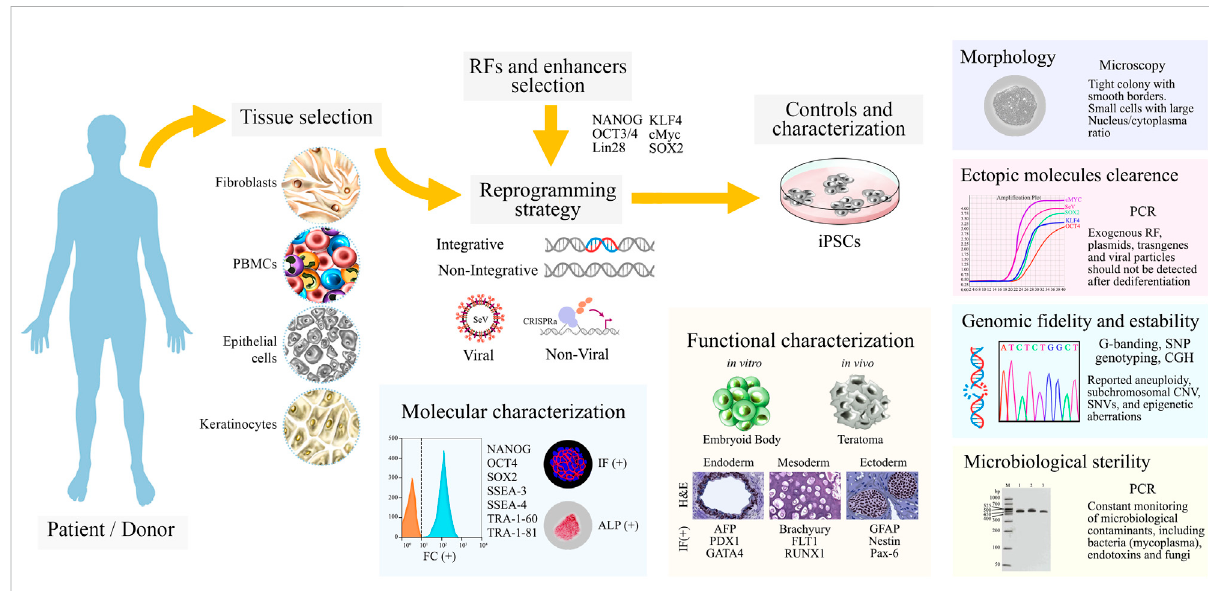
FIGURE 2 A schematic overview from patient ’ s tissue sample to characterized iPSCs cultures. Patient/donor samples are chosen, the four most frequent tissues are fi broblasts, blood cells, urine track epithelial cells and keratinocytes. Reprogramming factors (RFs), enhancers, and the reprogramming strategy are carefully selected. Once iPSCs cultures are obtained, controls and characterization assays are performed as shown. Abbreviations: SeV, Sendai virus; CRISPRa, CRISPR-Cas9-based gene activation; IF, immuno fl uorescence; ALP, alkaline phosphatase assay; H&E, hematoxylin and eosin; SNP, single-nucleotide polymorphism; CGH, comparative genomic hybridization; CNV, copy number